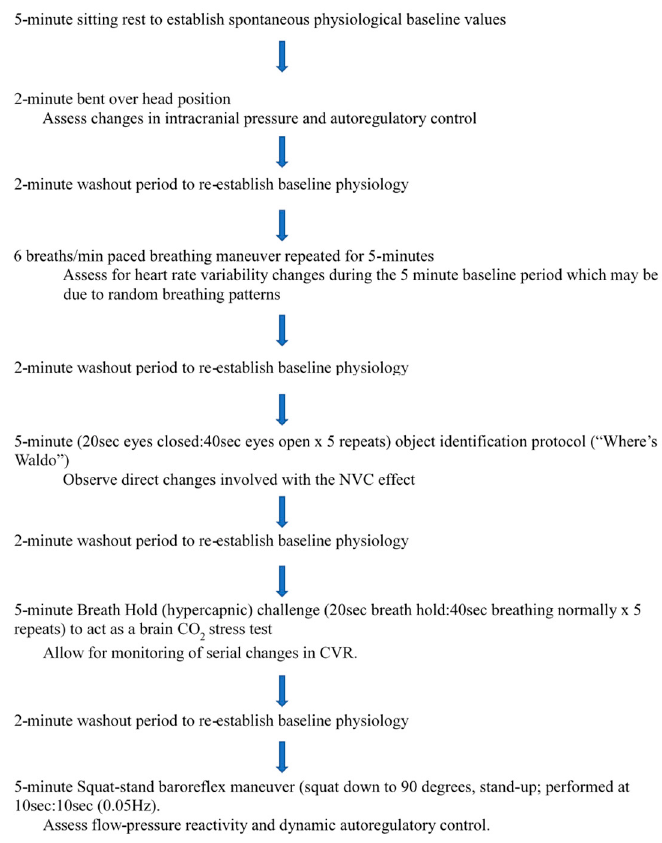
Figure 2. Cerebrovascular and Cardiovascular Testing Maneuvers (Neary Protocol).